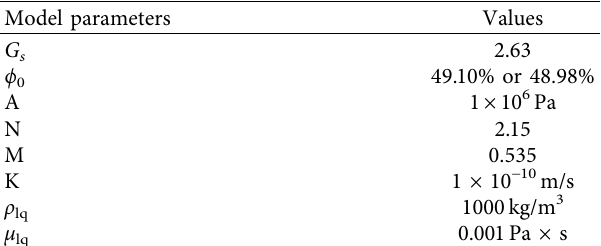
Figure 4: Geometry, boundary conditions, and mesh for clay soil. Table 3: Typical values of parameters.